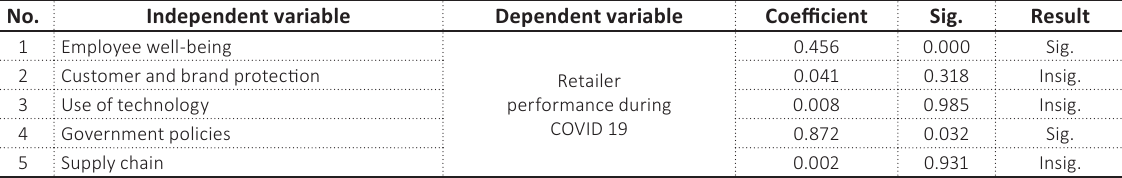
Table 7. Regression